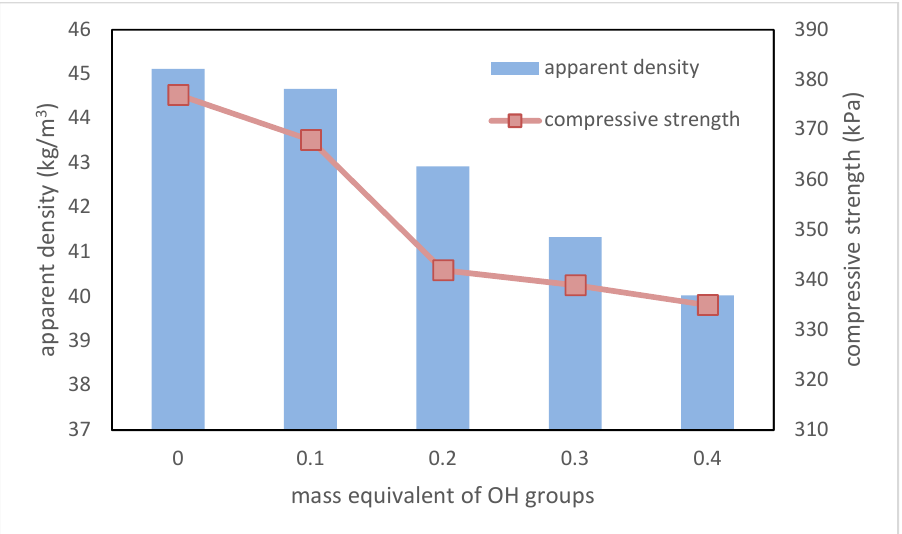
Figure 7. Dependence between EPB content, apparent density, and compressive strength in parallel direction to foam growth.